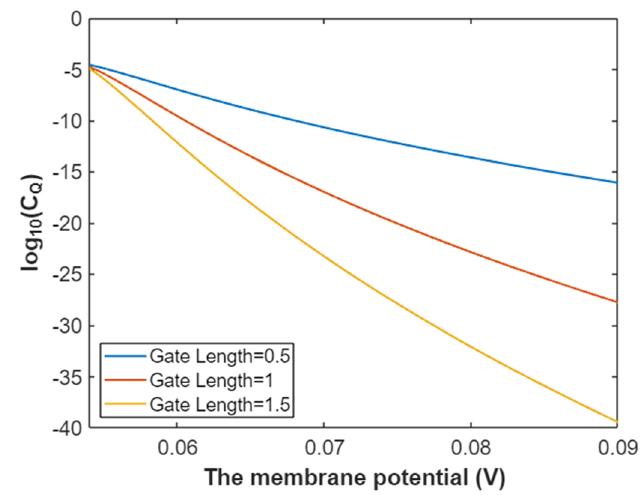
Figure 9. The relationship between membrane potential and the common logarithm of quantum conductance of a single sodium channel for extracellular sodium ions at G = 6.33 J and over a membrane potential range from 0.054 V to 0.09 V.